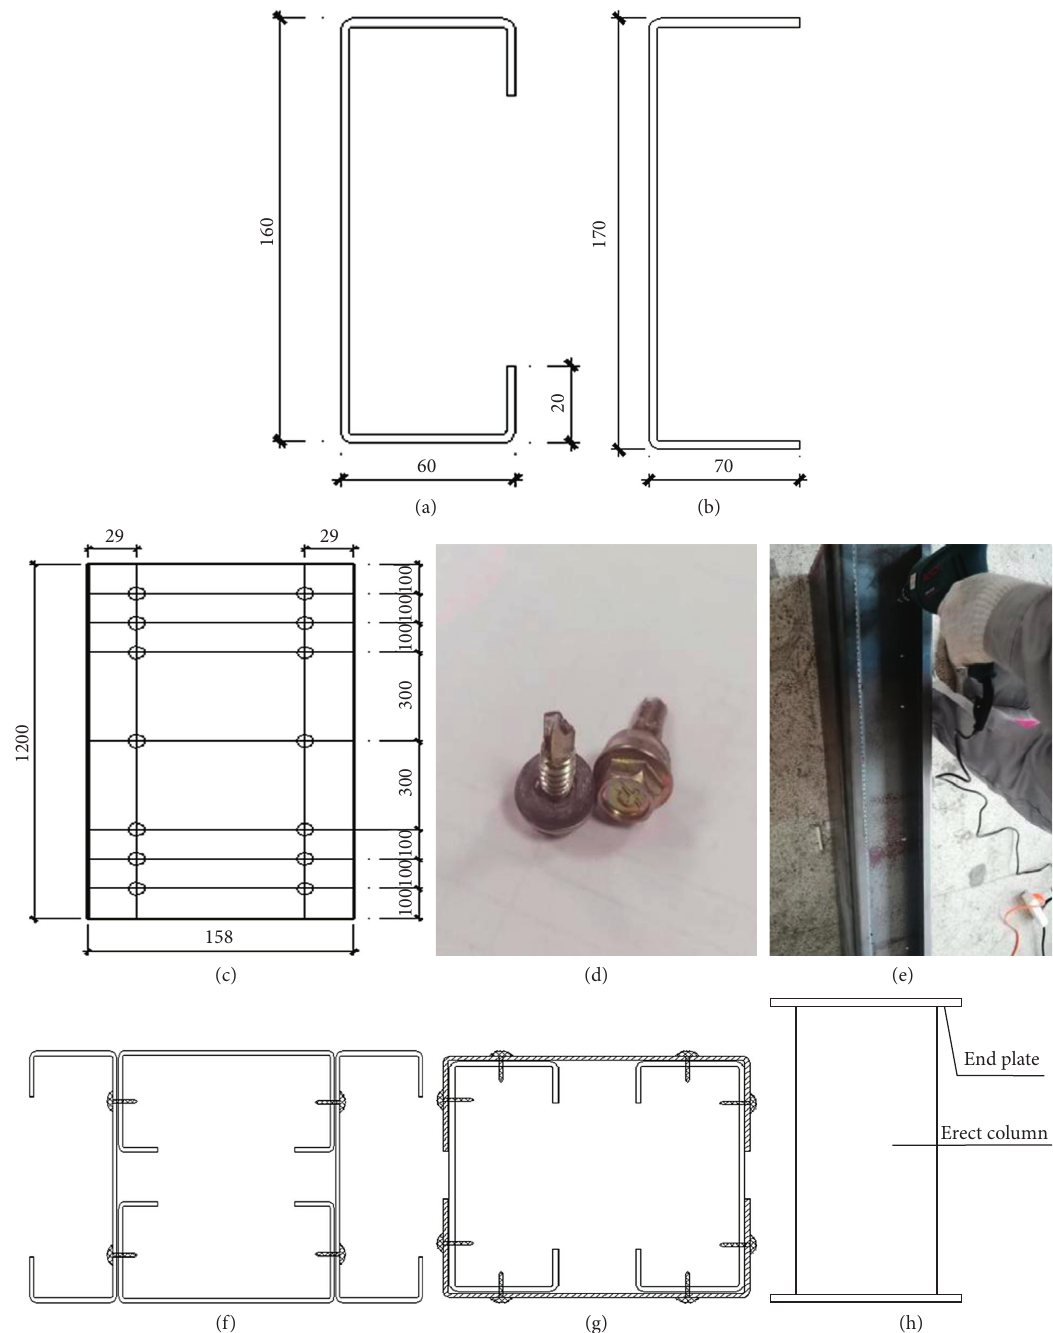
Figure 7: Fabrication of assembled section: (a) C-shaped steel, (b) U-shaped steel, (c) splicing plane diagram, (d) screw, (e) splicing indication, (f) 4C series, (g) CU series, and (h) end